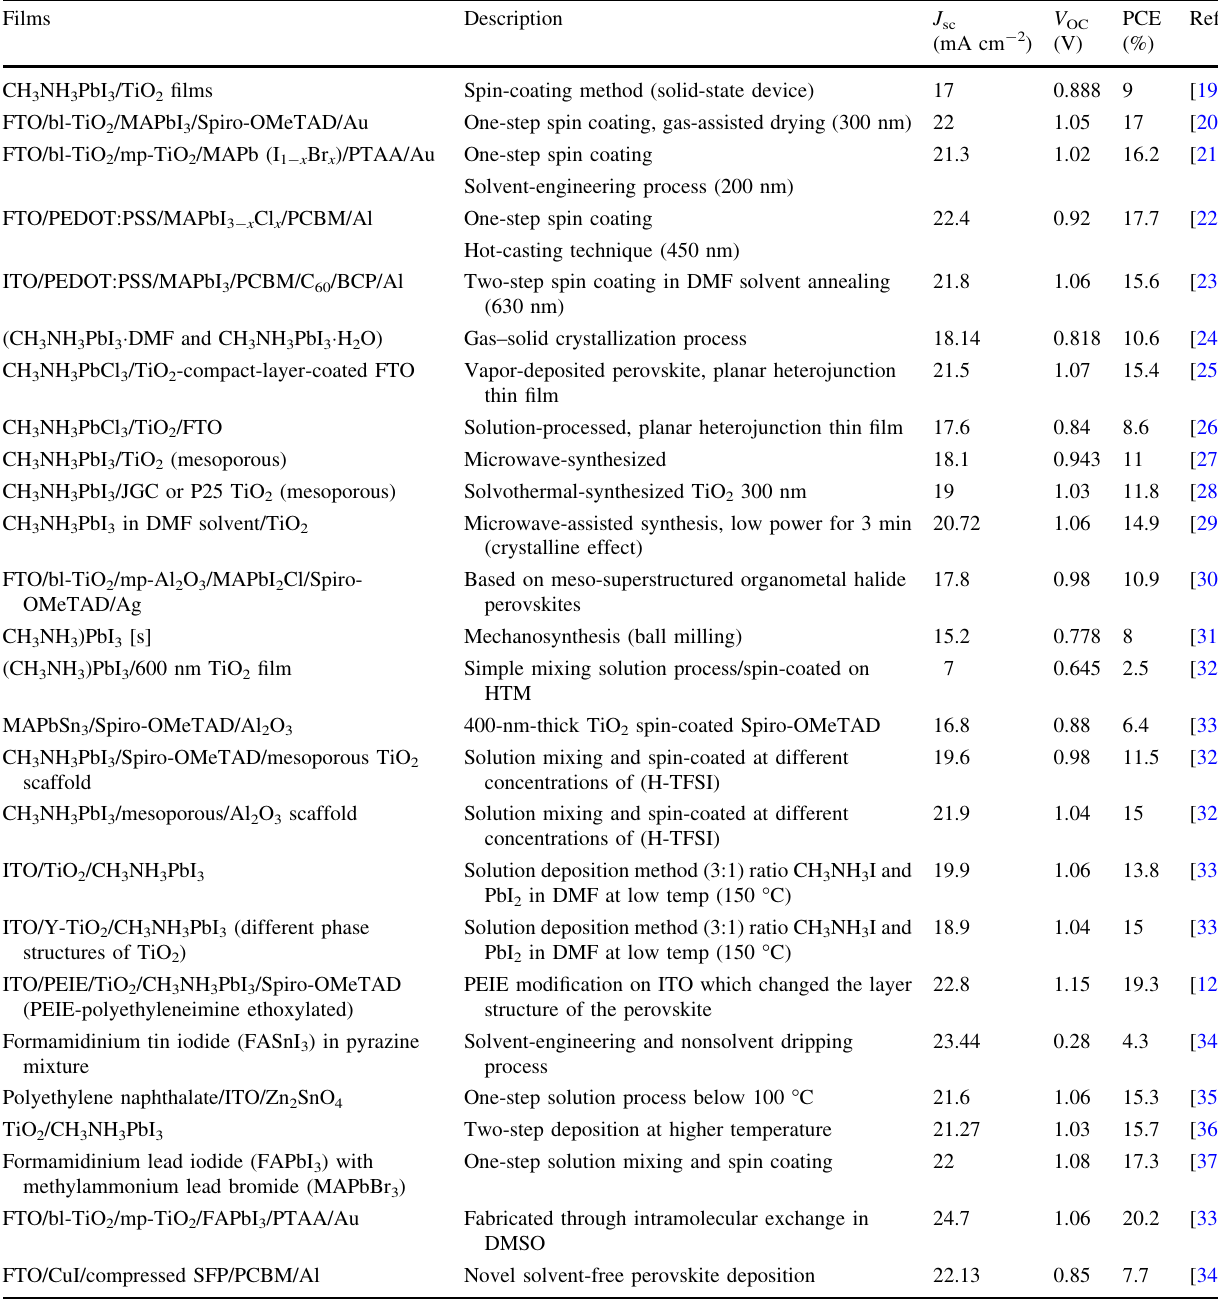
Table 1 Compiled summary of the reported performance for the perovskite solar cells with synthesis and modification approach method